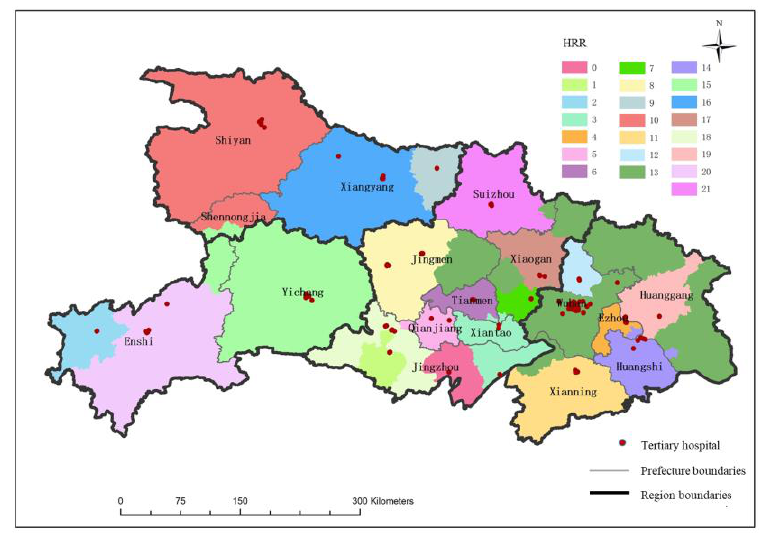
Figure 6. Spatial distribution of maternal HRRs.